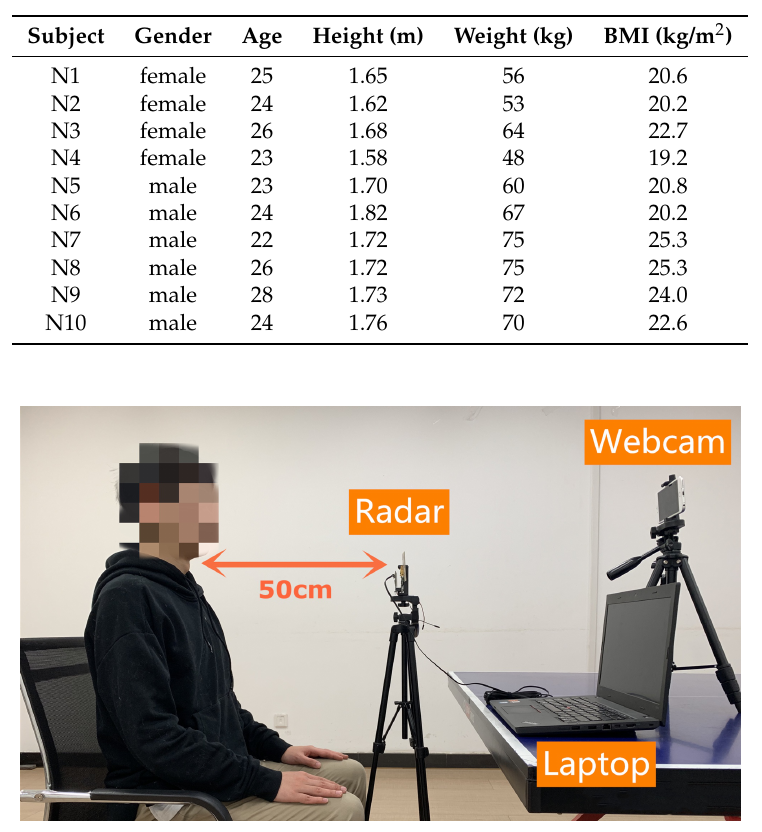
Figure 7. Experimental